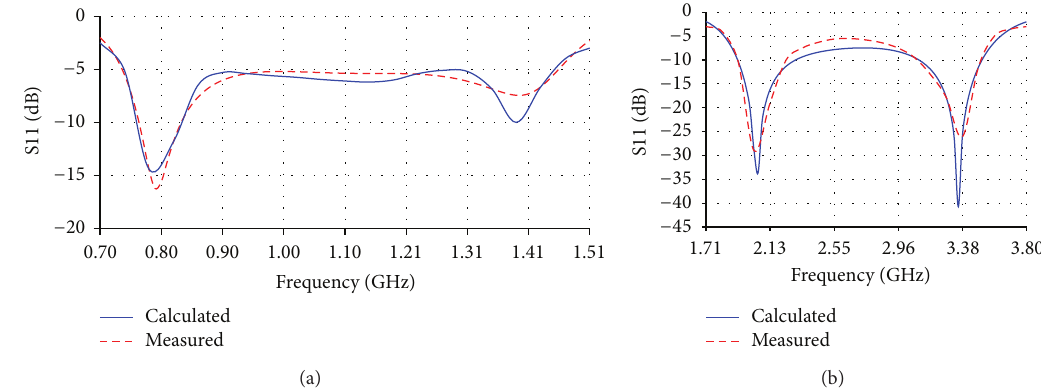
Figure 6: Return loss of (a) the reduced size version of the low band antenna and (b) the reduced size version of the high band